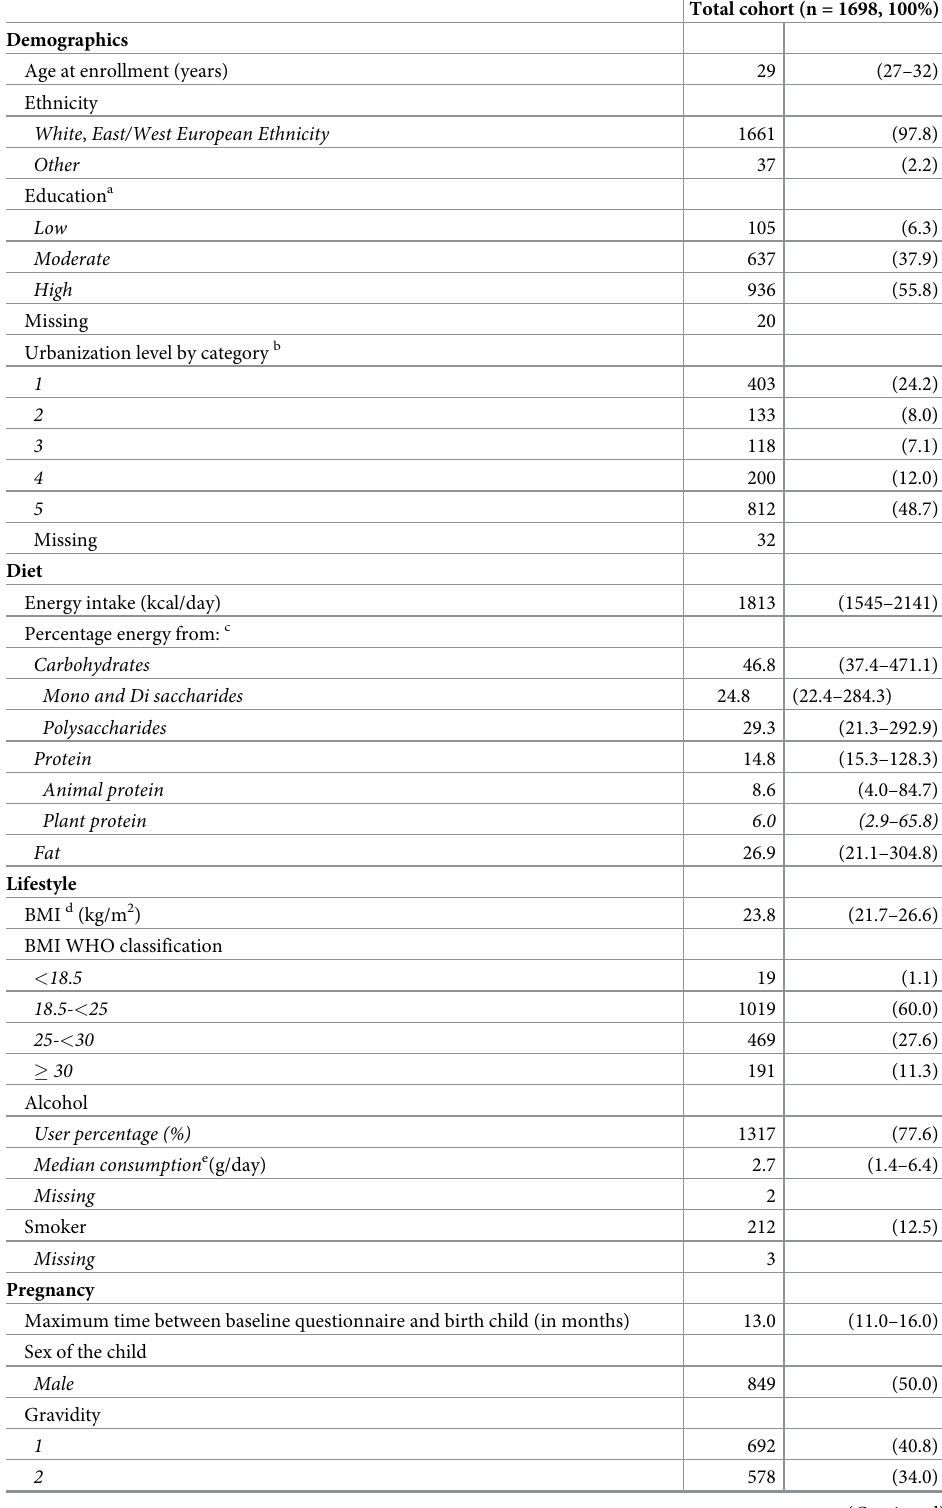
Table 1. Characteristics of the Perined-Lifelines linked birth cohort (N =